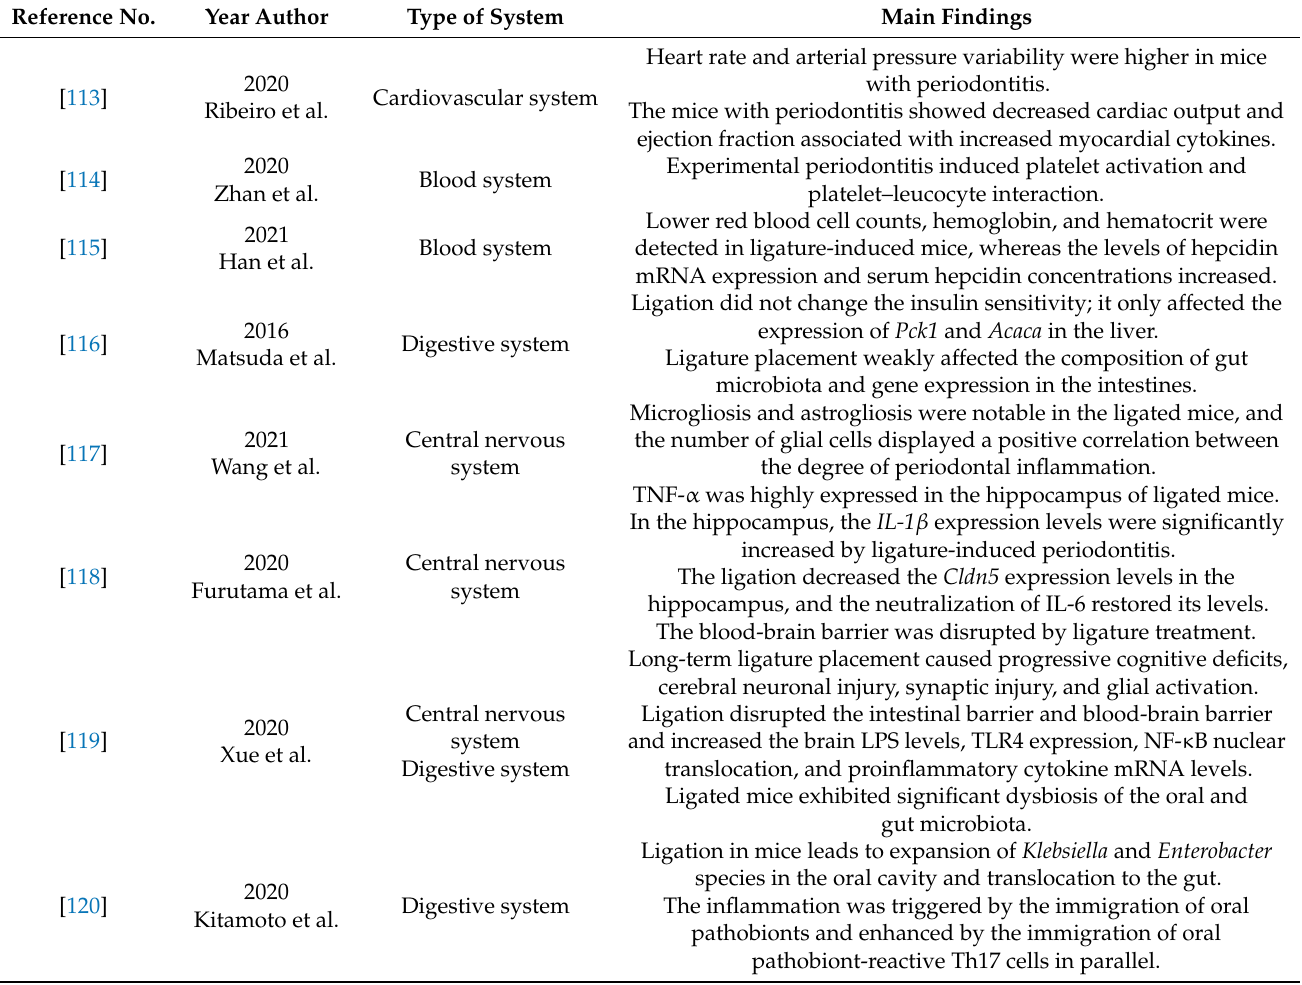
Table 3. Summary of systemic effects of periodontitis found using ligature